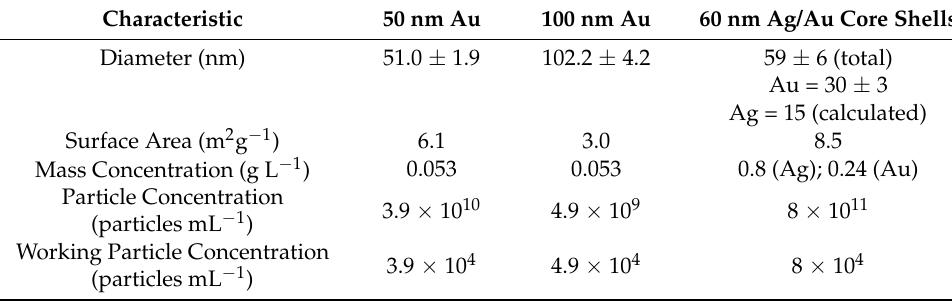
Table 1. Relevant characteristics of the nanoparticle samples.